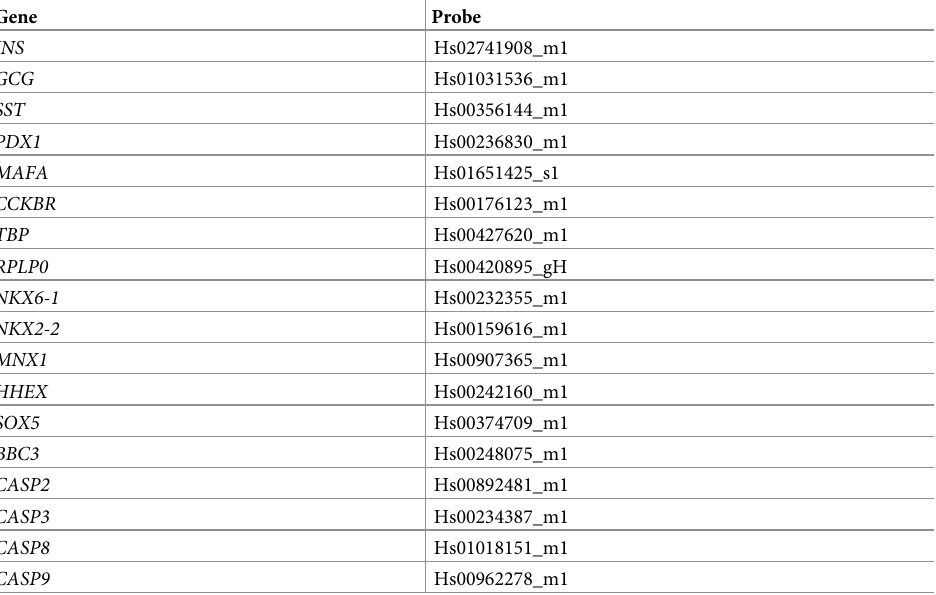
Table 2. Assay-on-Demand (Applied Biosystems) TaqMan fluorogenic probes used in the study. Gene